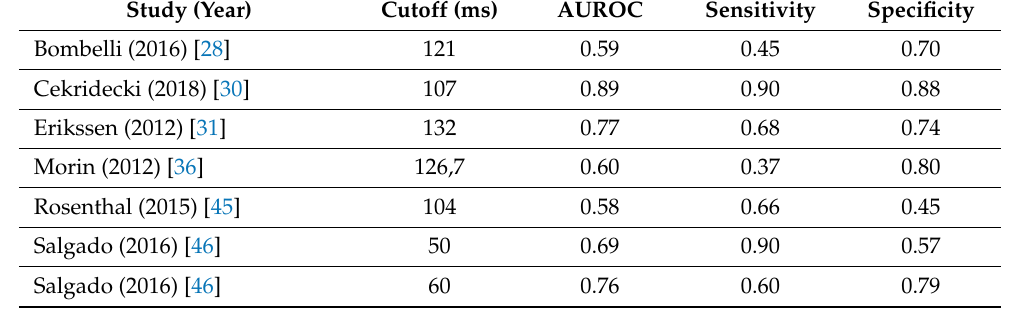
Table 2. List of studies reporting area under the receiver operating characteristics (AUROC) curves to predict all-cause death by Tpeak-Tend interval.